Question: What does this figure show? Answer in one sentence.
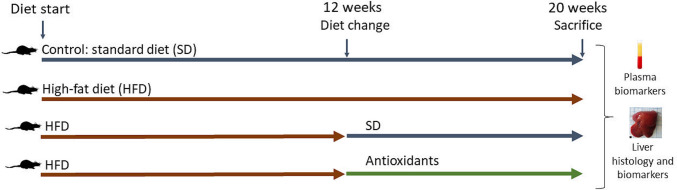
Answer: Timeline of the experimental procedure. Control rats were fed a standard food; one group of rats were fed a HFD for 20 weeks; the other two groups were fed a HFD for 12 weeks, and afterwards diet was changed to standard food or diet rich in antioxidants. The nutritional intervention was performed for both sexes. At the end of the experiment (five months), rats were sacrificed, and plasma and liver were used for histological and biomarkers determinations